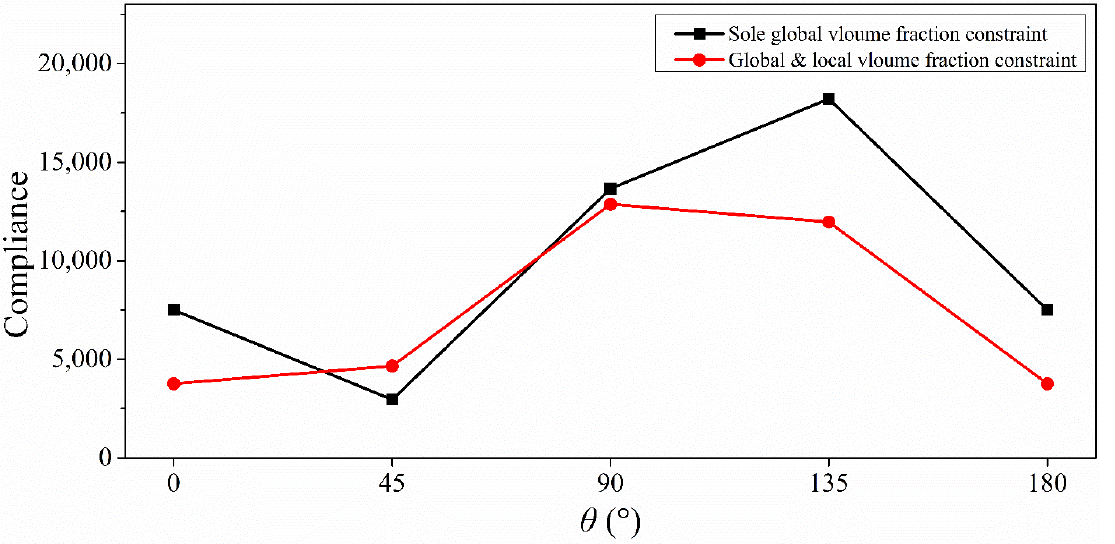
Figure 11. Compliance curves with respect to load direction angle θ of two resulting topologies.